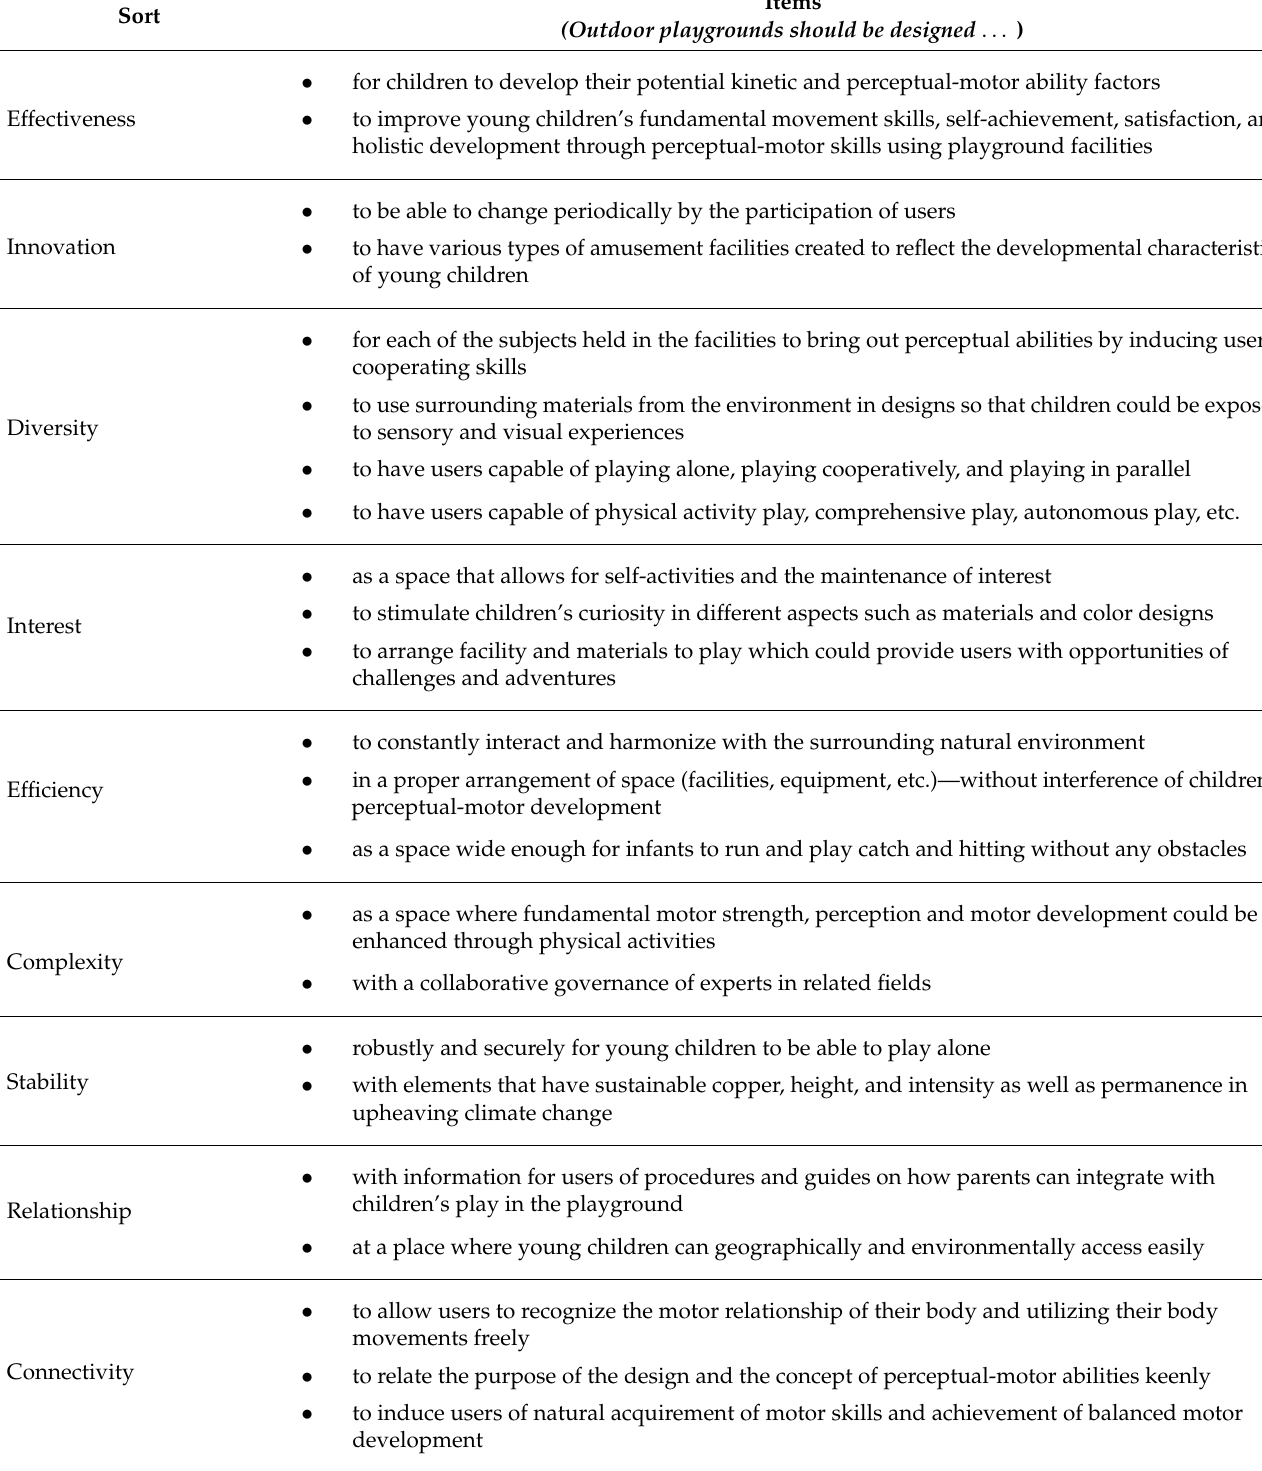
Table 6. Outdoor Playground Design Criteria of Fundamental Movement Skills and Perceptual-motor abilities. Sort